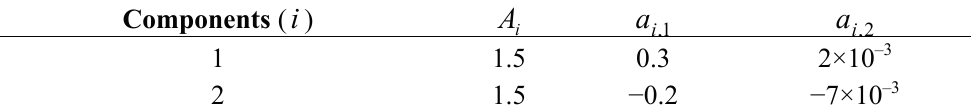
Table 1. Parameters of the two-component LFM